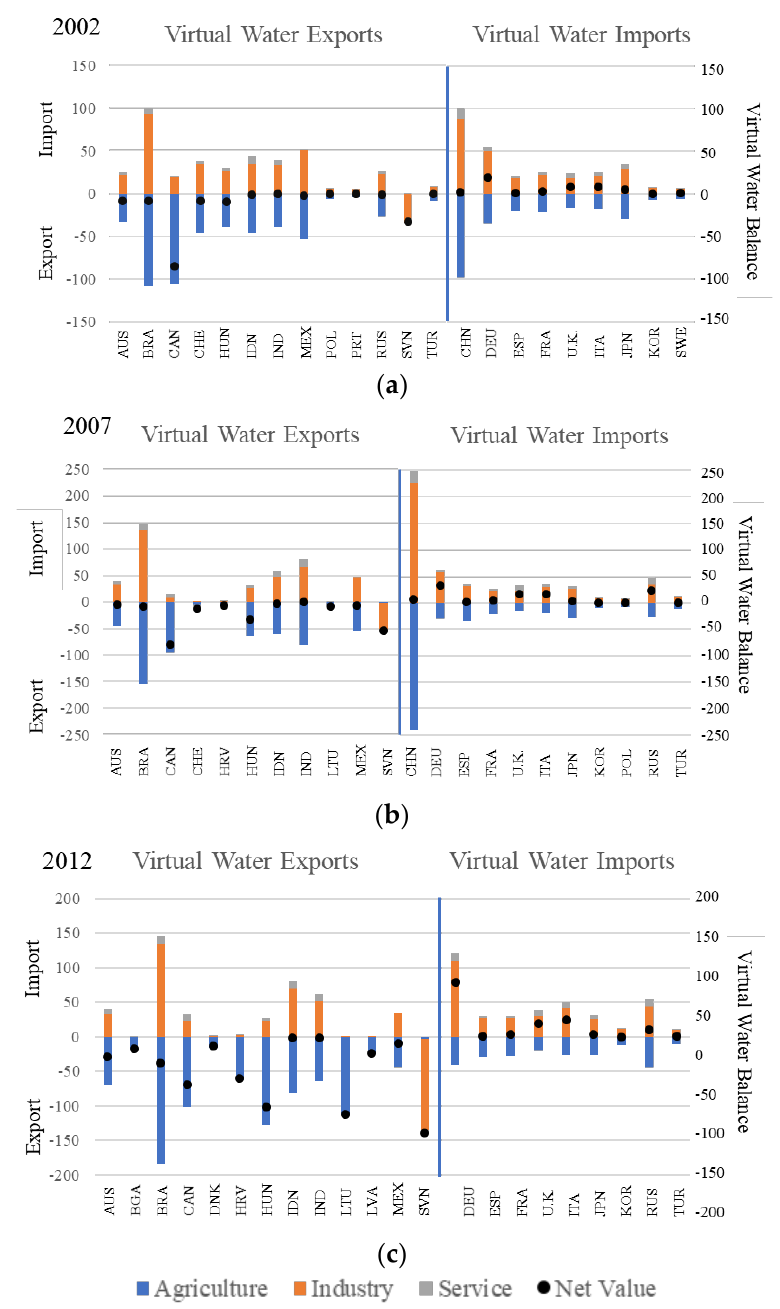
Figure 3. Virtual water flows for different industries during 2002 – 2012 in 22 countries.